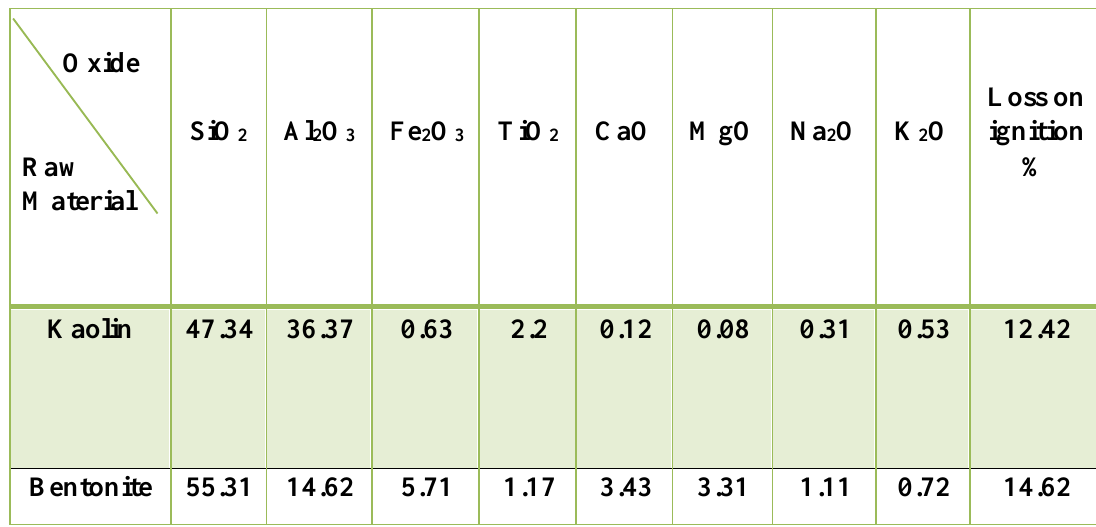
Table 1: Chemical compositions for kaolin and bentonite.